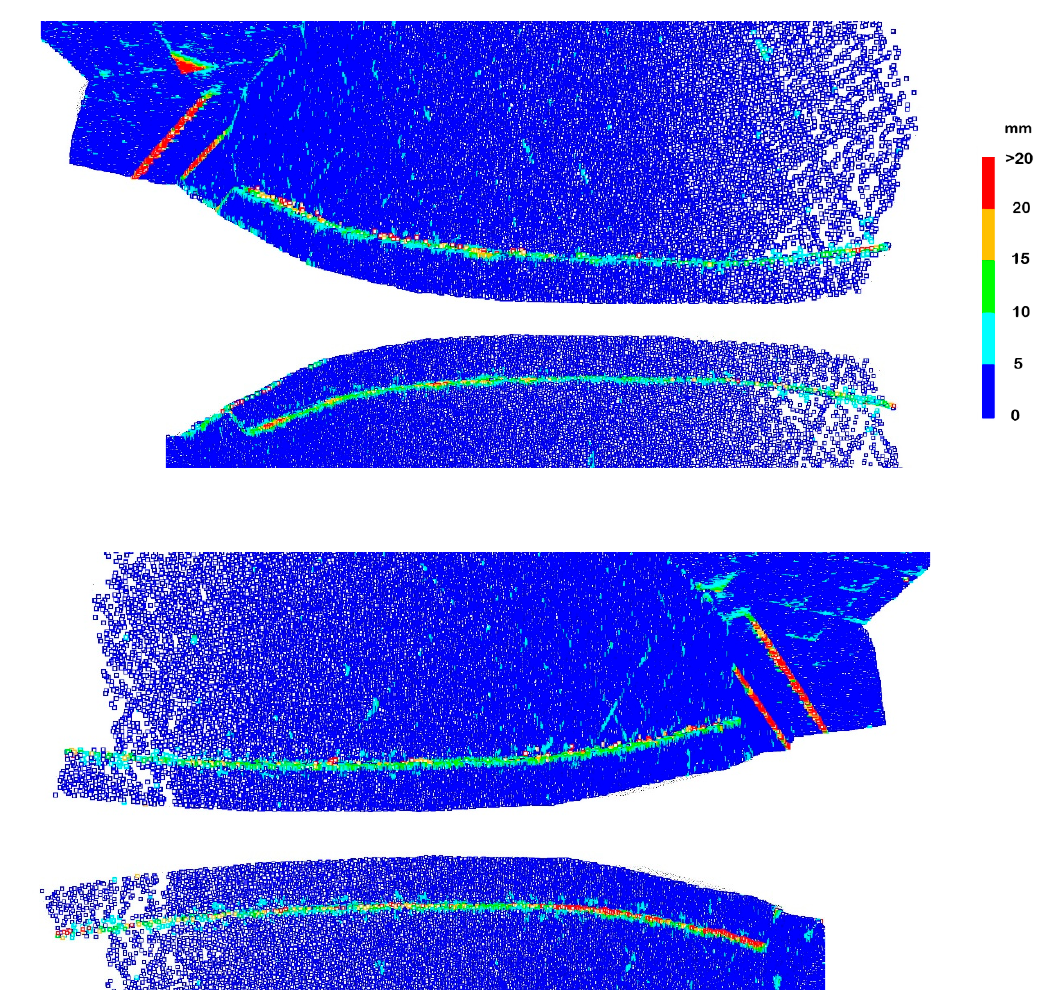
Figure 12. Deviations for edge configurations in Figure 8: two-edge, four-edge, two-edge with a gap. Views of the left and right parts of surfaces 6 and 7, flange of surface 7 visible from outside and inside.